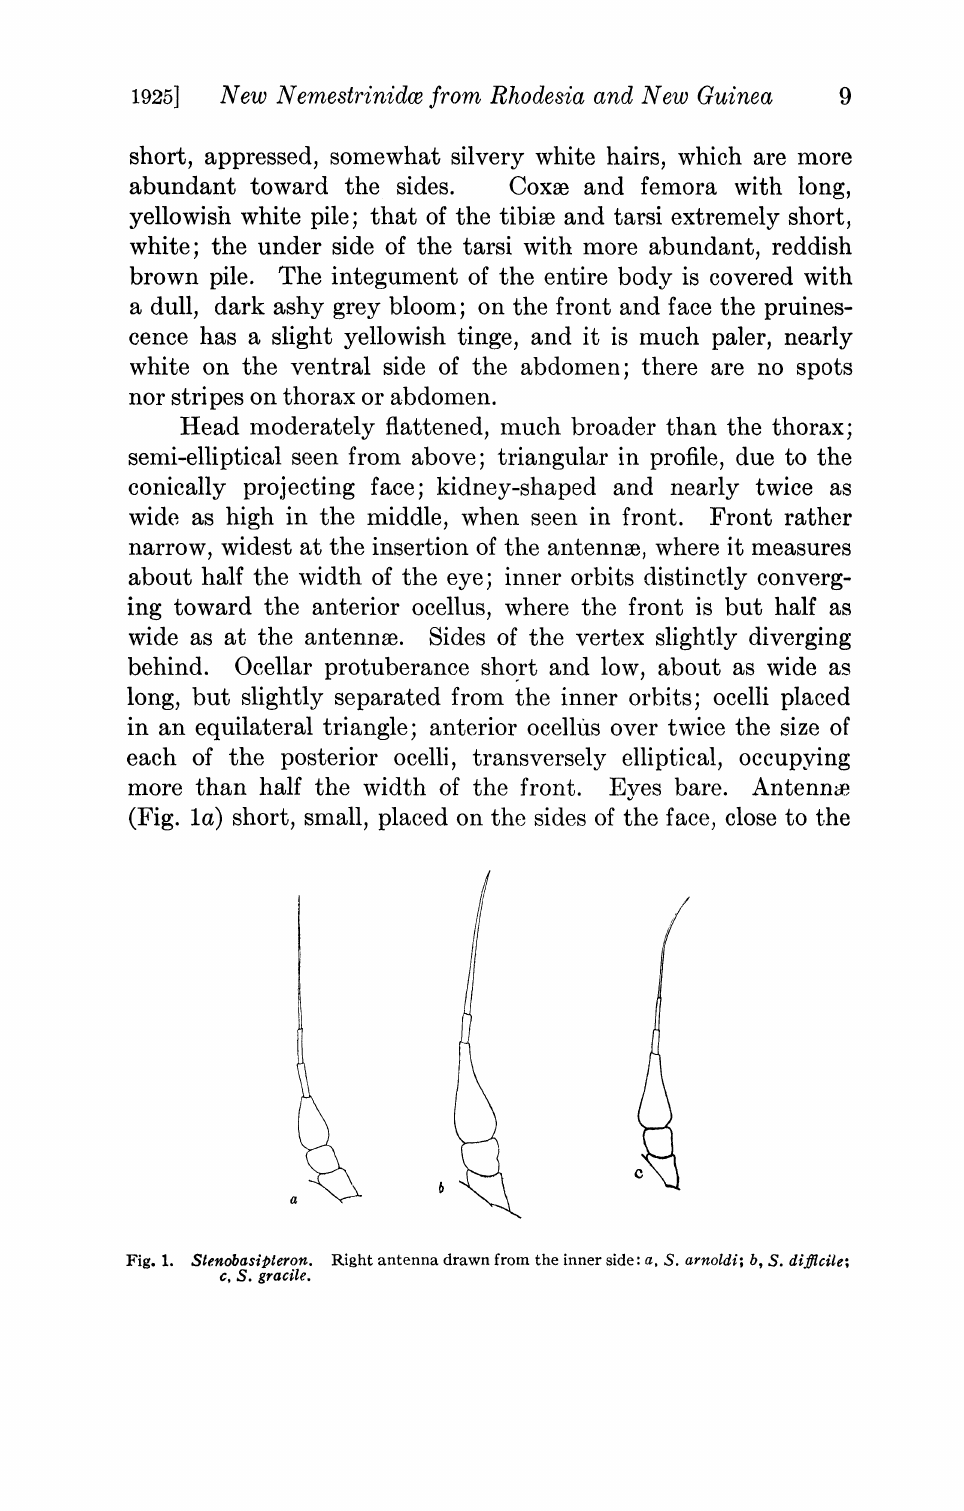
Fig. 1. Stenobasipteron. Right antenna drawn from the inner side: a, S. arnoldi; b, S. difficile; ,